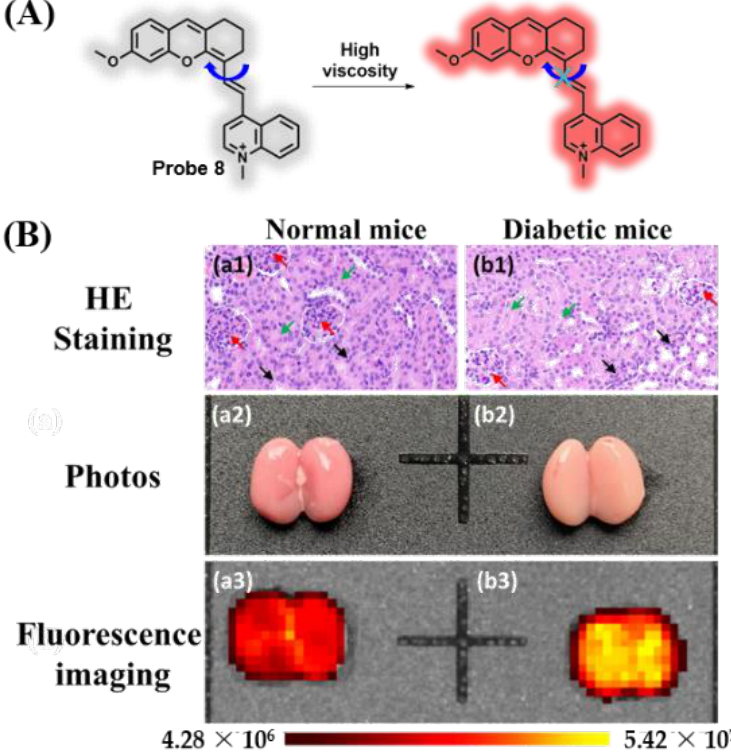
Figure 6. ( A ) Imaging mechanism of probe 8 ; ( B ) HE staining, photos, and fluorescence imaging of the kidney in a normal mouse and a diabetic mouse treated with probe 8 , respectively; HE staining of ( B - a1 ) normal mouse kidney and ( B - b1 ) diabetic mouse kidney; photos of ( B - a2 ) normal mouse kidney and ( B - b2 ) diabetic mouse kidney; fluorescence imaging of ( B - a3 ) normal mouse kidney and ( B - b3 ) diabetic mouse kidney, λ ex / em = 560/740 nm. Adapted from Reference [62]. Copyright 2021, Elsevier